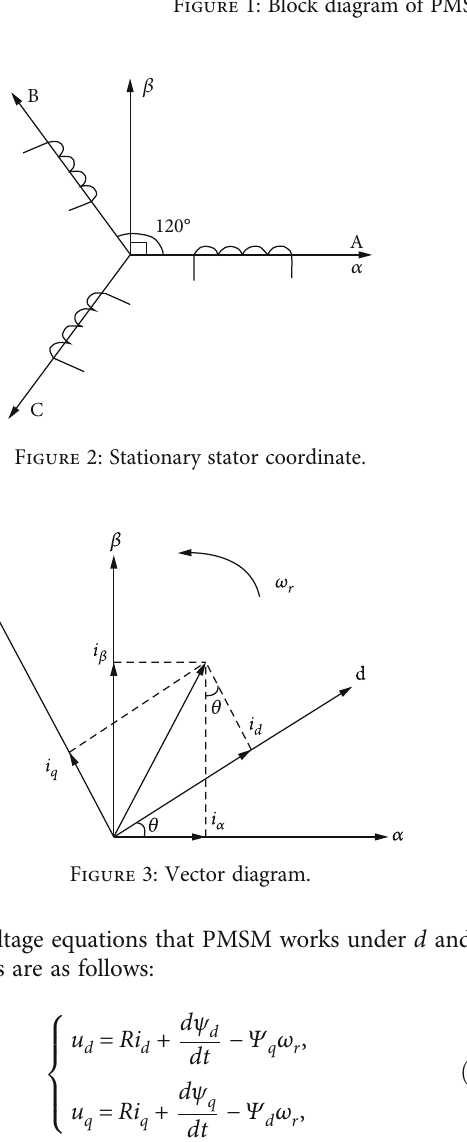
Figure 1: Block diagram of PMSM sensorless control system based on LO.